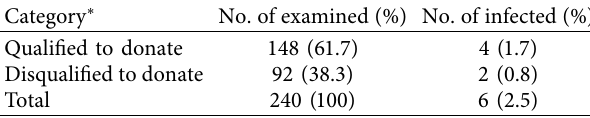
Table 2: Prevalence of malaria parasitemia in examined donors.